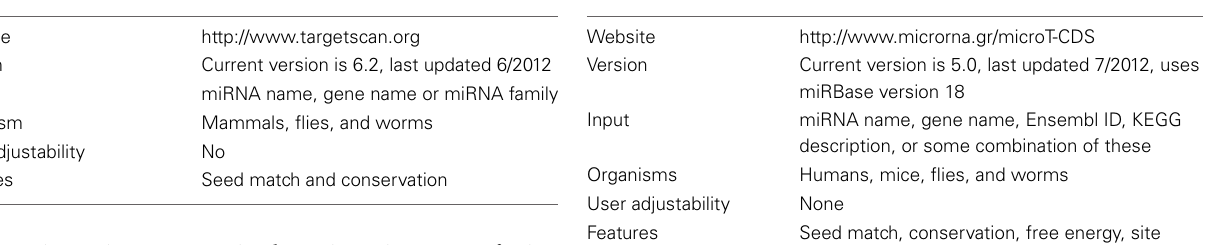
Table 3 | Profile of TargetScan. Table 4 | Profile of